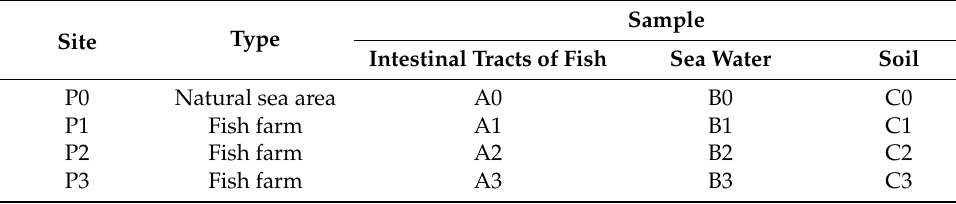
Figure 1. Map of the sampling location and sampling sites: The four sampling sites were P0 (117.935° E, 39.0415° N), P1 (117.626544° E, 38.852927), P2 (117.912634° E, 39.304451) and P3 (117.964958° E, 39.264878) in the west of the Bohai Sea, in northeast China. Table 1. Samples from different sites.